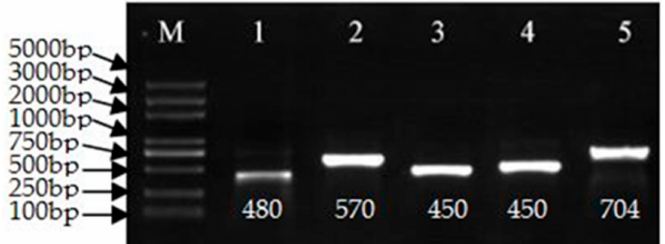
Figure 2. Polymerase chain reaction (PCR) confirmation of the pCaLFGmFNLFG vector. M: Marker 5000. PCR amplicons obtained using the following primer pairs: 1, GMHSP-F/GMHSP-R; 2, F3t/R3t; 3, Fmid/Rmid; 4, GUS-nptII-F/ GUS-nptII-R; and 5, FLP-35SF/ FLP-35SR. Bp: base